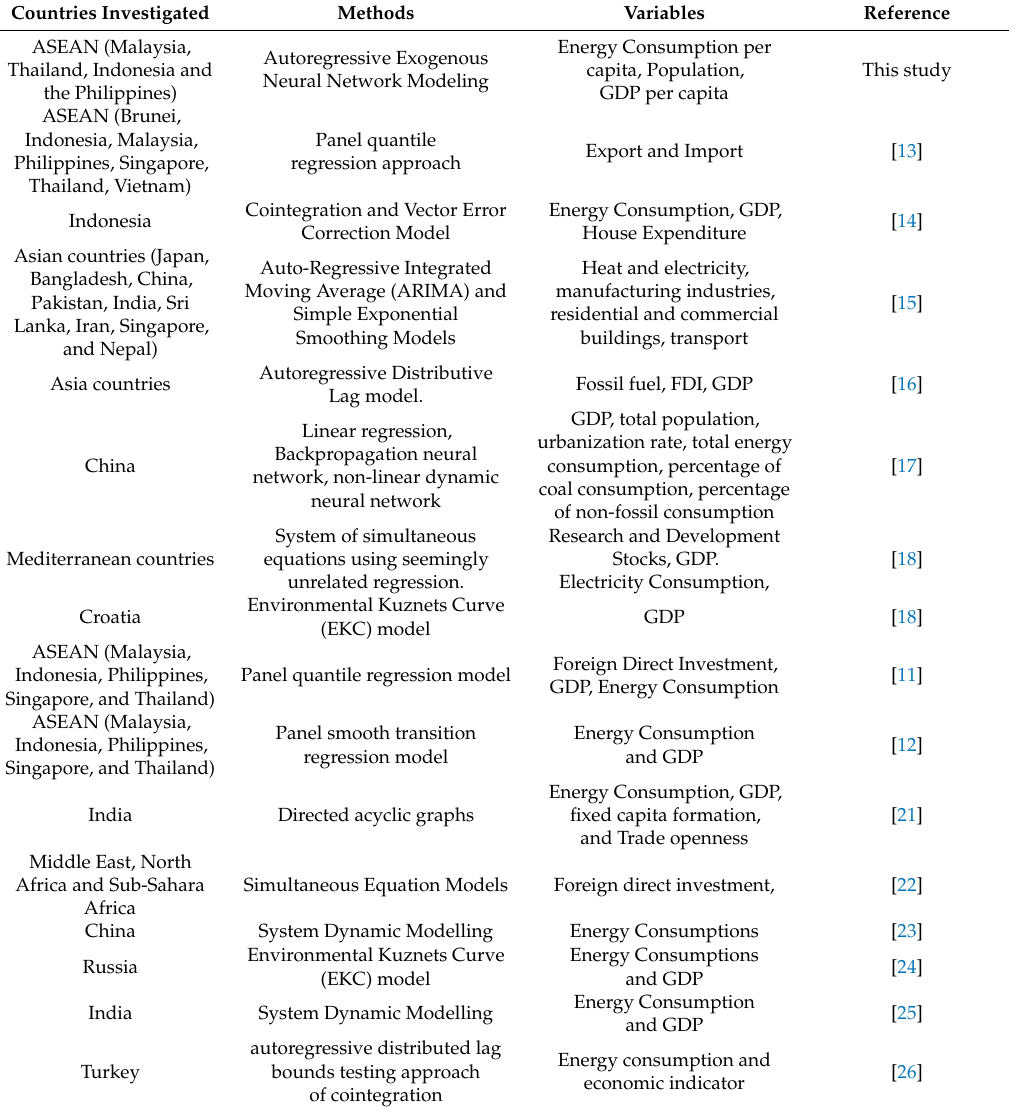
Table 1. Summary of literature on modelling of CO 2